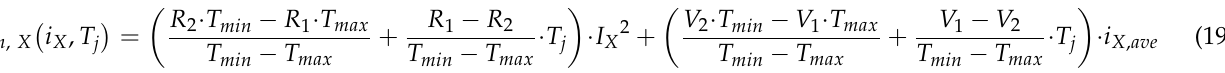
Table 4. Nominal values used in Equation (19).